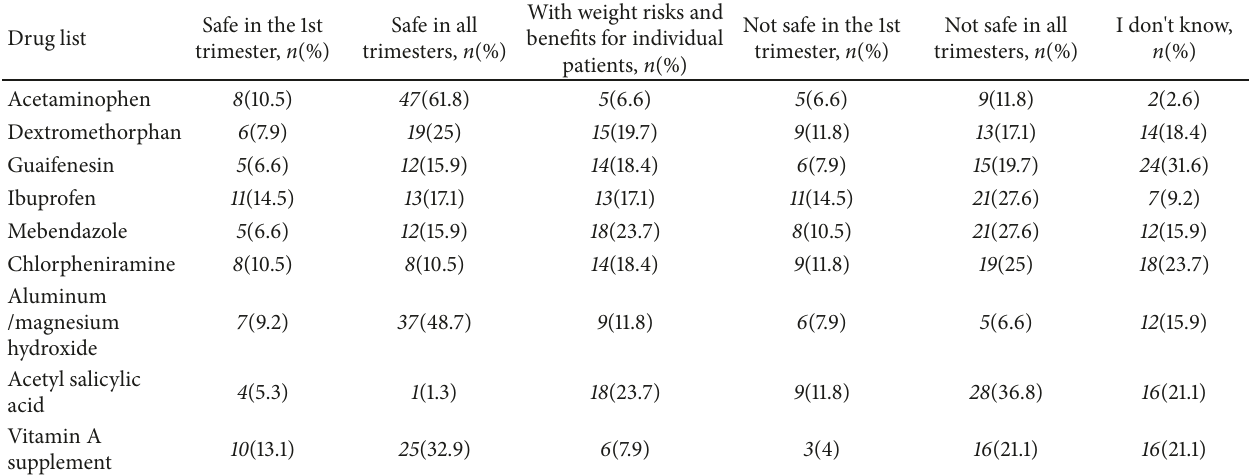
Table 3: Results of medication safety during pregnancy test for pharmacy professionals (OTC). Drug